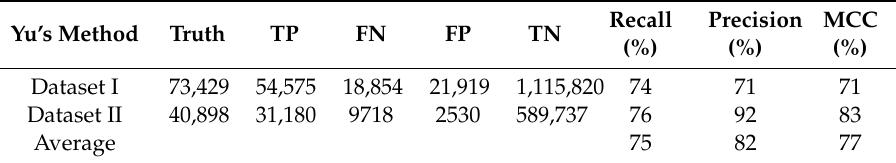
Table 1. Quantitative evaluation of road marking extraction using Yu’s method [16].